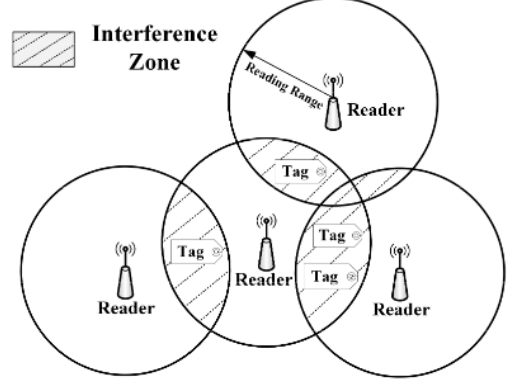
Fig. 4. Reader collision in a more complex setting, several readers try to communicate with similar tags [33].